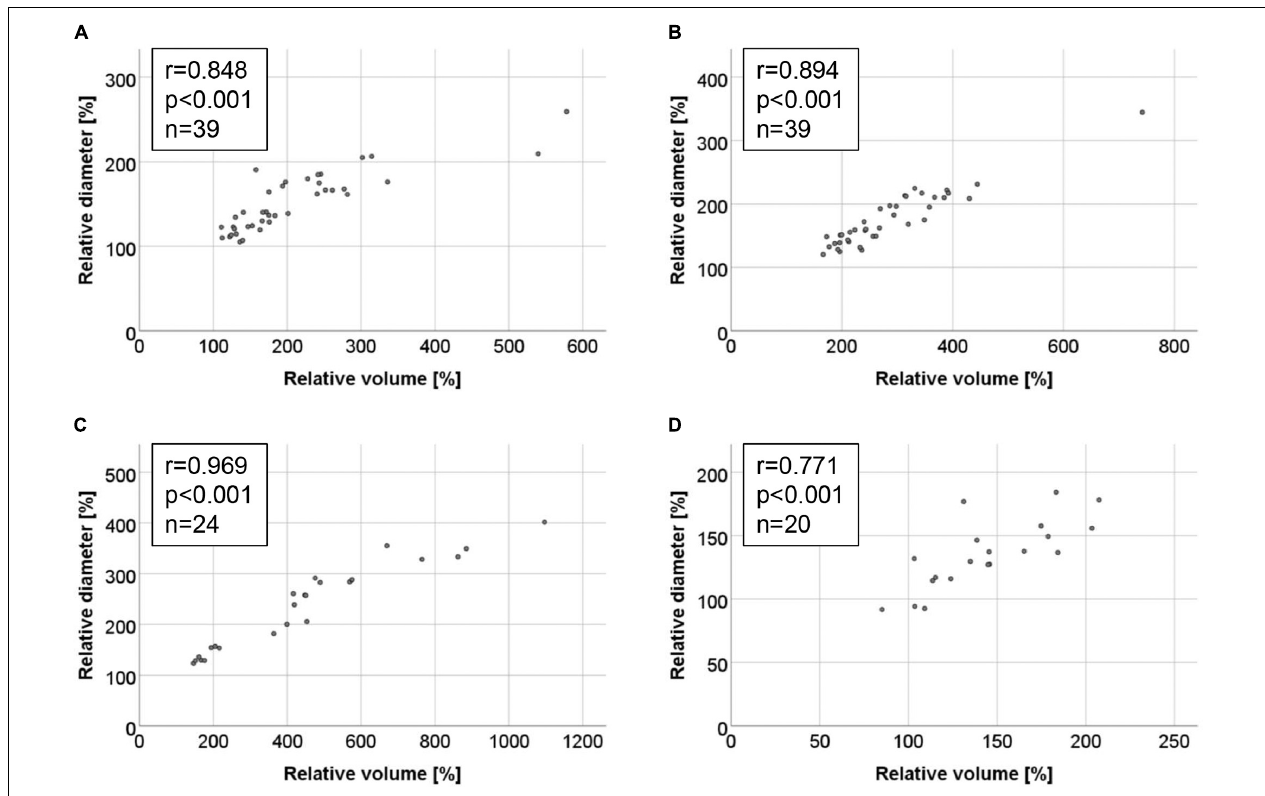
FIGURE 6 | Correlations between relative increase in aneurysm volume and maximum aortic diameter in the four AAA mouse models. Correlations are illustrated by scattergram for the (A) AngII model, (B) ePPE model, (C) ePPE + BAPN model, and (D) PPE model. Baseline values were set to 100% and are hence excluded from the graph and Spearman coefficient of